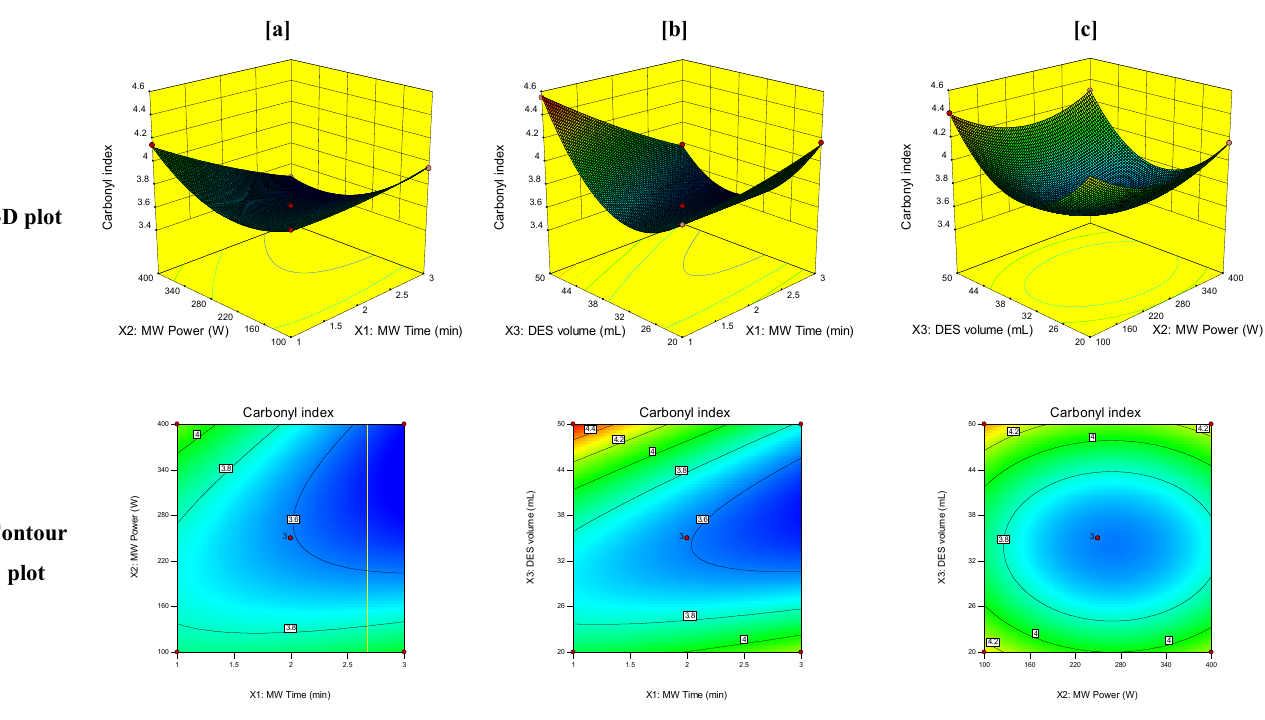
Figure 4. 3D and contour plots of the effect of the interaction of ( a ) MW time (X 1 ) and MW power (X 2 ), ( b ) MW time (X 1 ) and volume of DES (X 3 ), and ( c ) MW power (X 2 ) and volume of DES (X 3 ) on the carbonyl index.